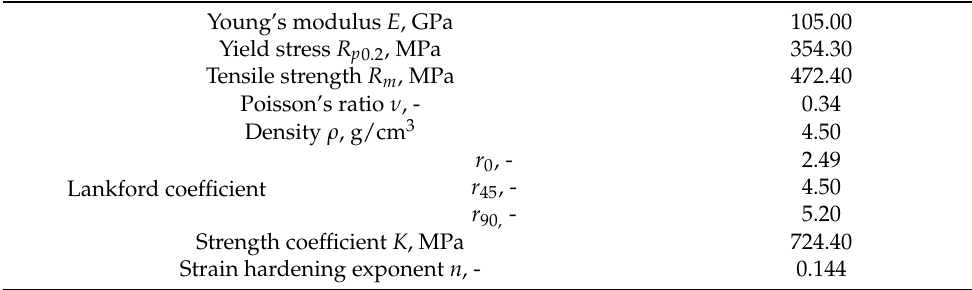
Table 2. Material data for Grade 2 commercially pure titanium sheet t = 1 mm.